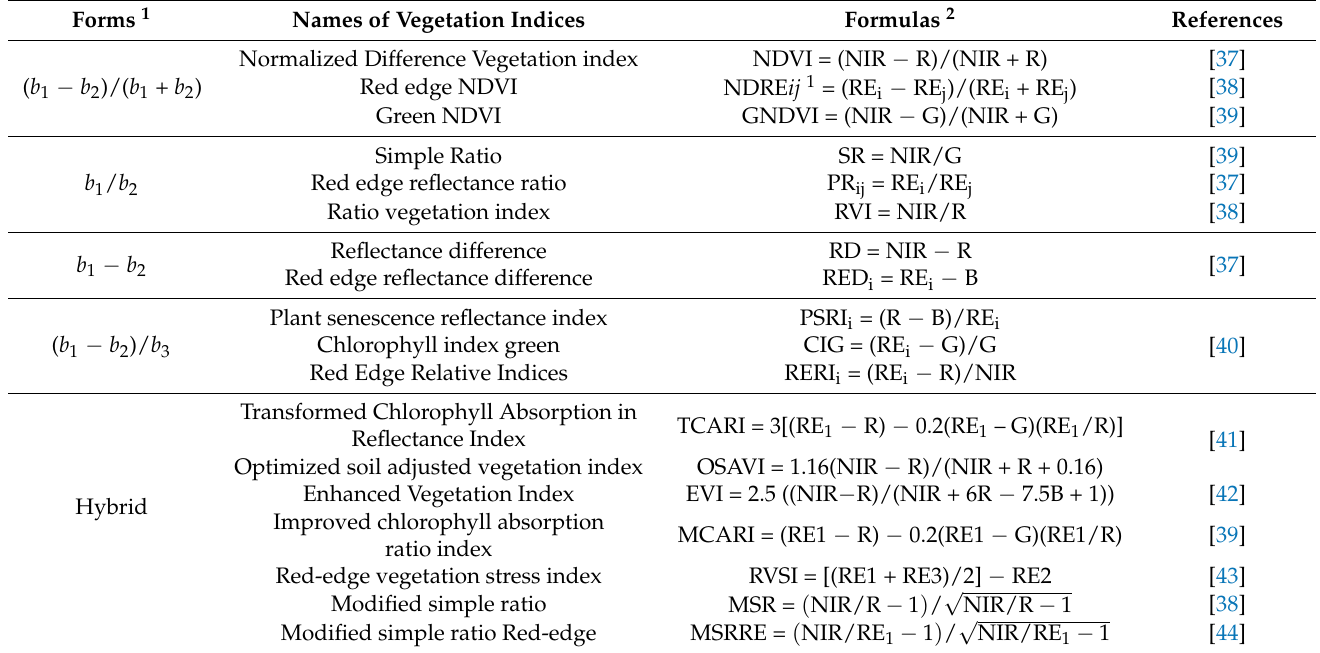
Table 1. Vegetation indices were used in this